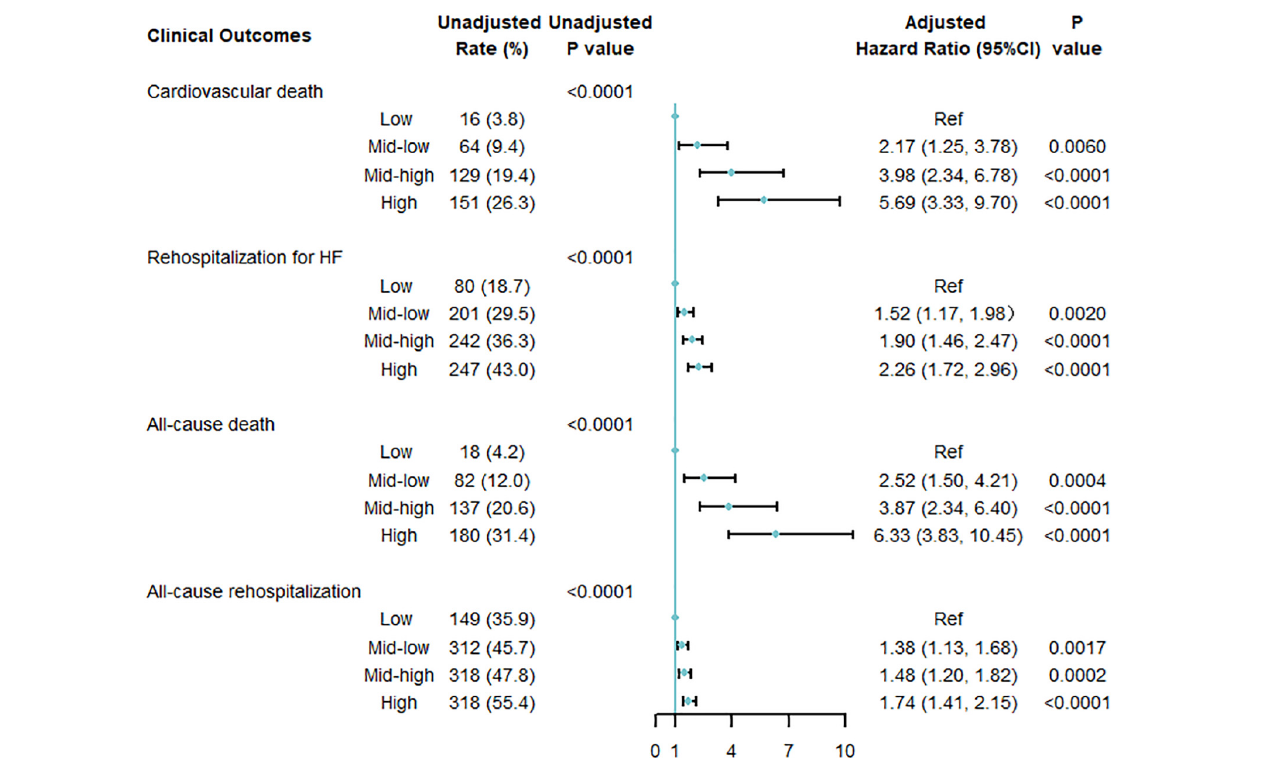
FIGURE 3 | Multi-variable adjusted association between multi-biomarker group and 1-year clinical outcomes (validating cohort). Adjusted for age, sex, systolic blood pressure, heart rate, New York Heart Association classification, history of hypertension, atrial fibrillation, coronary heart disease, valvular heart disease, previous heart failure, current smoking [yes or no], heart failure phenotypes [HF with reduced ejection fraction (HFrEF), HF with mildly reduced ejection fraction (HfmrEF), or HF with preserved ejection fraction (HFpEF)], discharge use of angiotensin-converting enzyme inhibitors or angiotensin receptor blockers, β -blockers, diuretics, and aldosterone